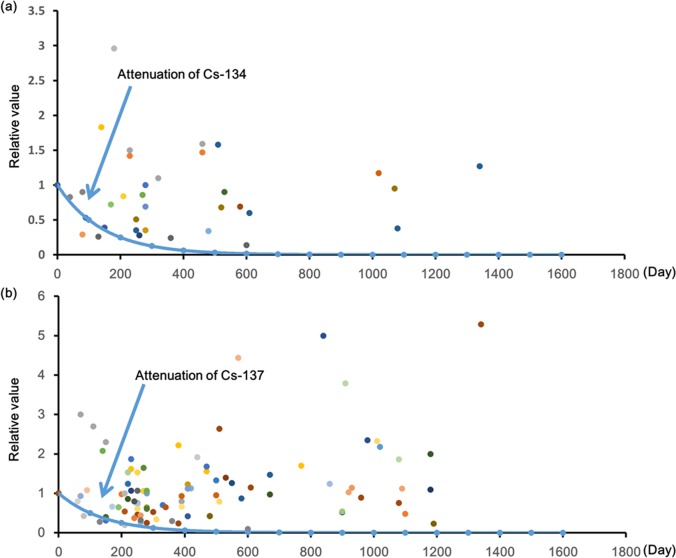
Changes in radioactivity over time for individuals detected with radioactivity.These graphs show the radioactivity attenuation ratio [Bq] for persons who underwent multiple WBC tests. For these tests, the radioactivity at the time of initial inspection is considered one. The decay curve is the curve when the mean value of the effective half-life of Cs-134, and Cs-137 is considered as 100 days. The data represents radioactivity detected in 61 and 22 persons for Cs-137 and Cs-134 respectively after multiple tests.